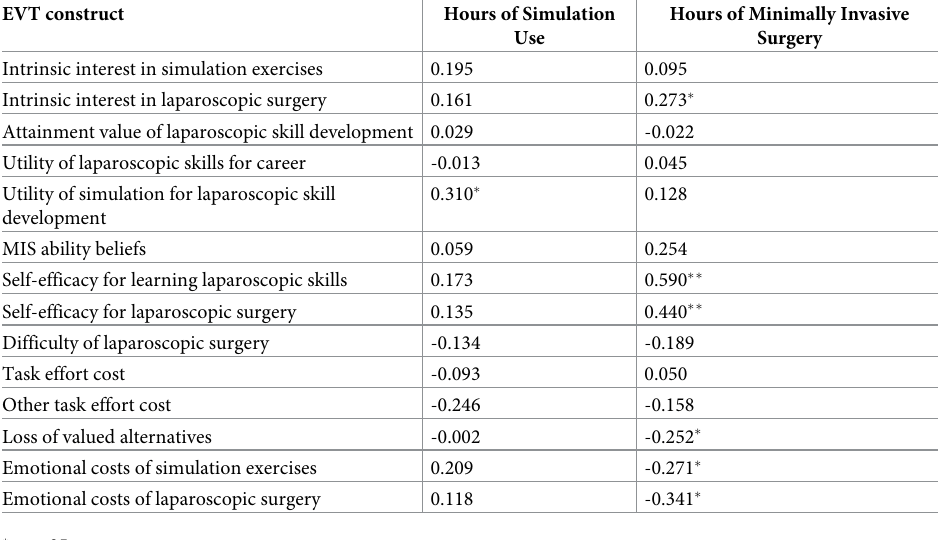
Table 2. Spearman’s rho correlations between expectancy-value constructs, simulation use, and surgical experience. EVT